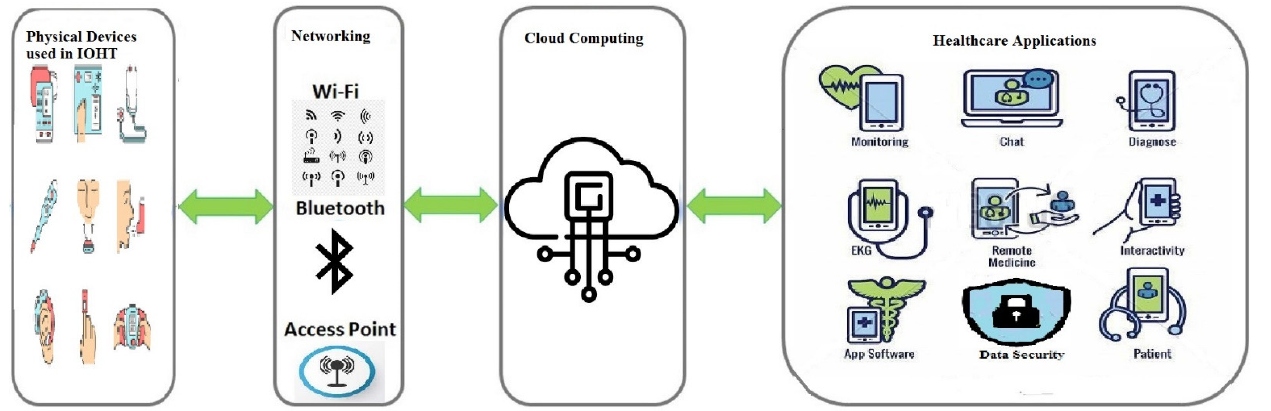
Figure 2. IOHT system architecture.